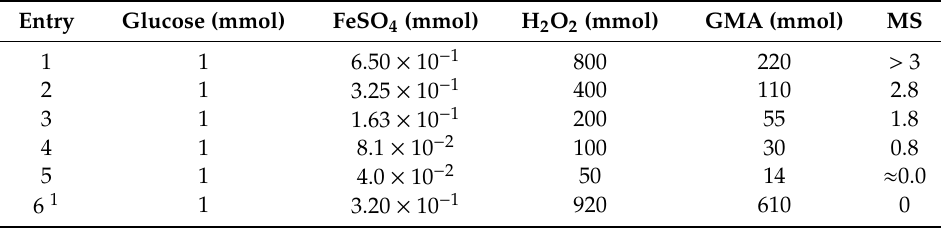
Table 1. Fenton-type glycidylmethacrylate (GMA) grafting. Relationship between reagent molar ratio